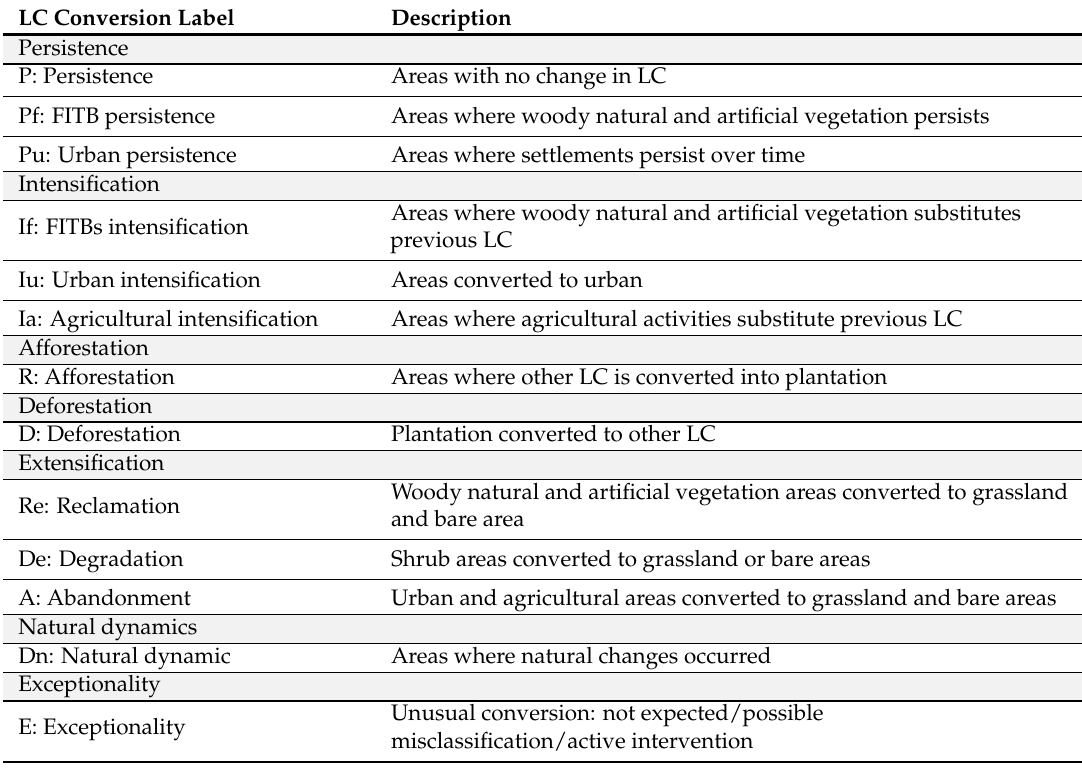
Table 2. Labels and descriptions for conversion patterns and trajectories. Main trajectories of LCC highlighted with grey background.